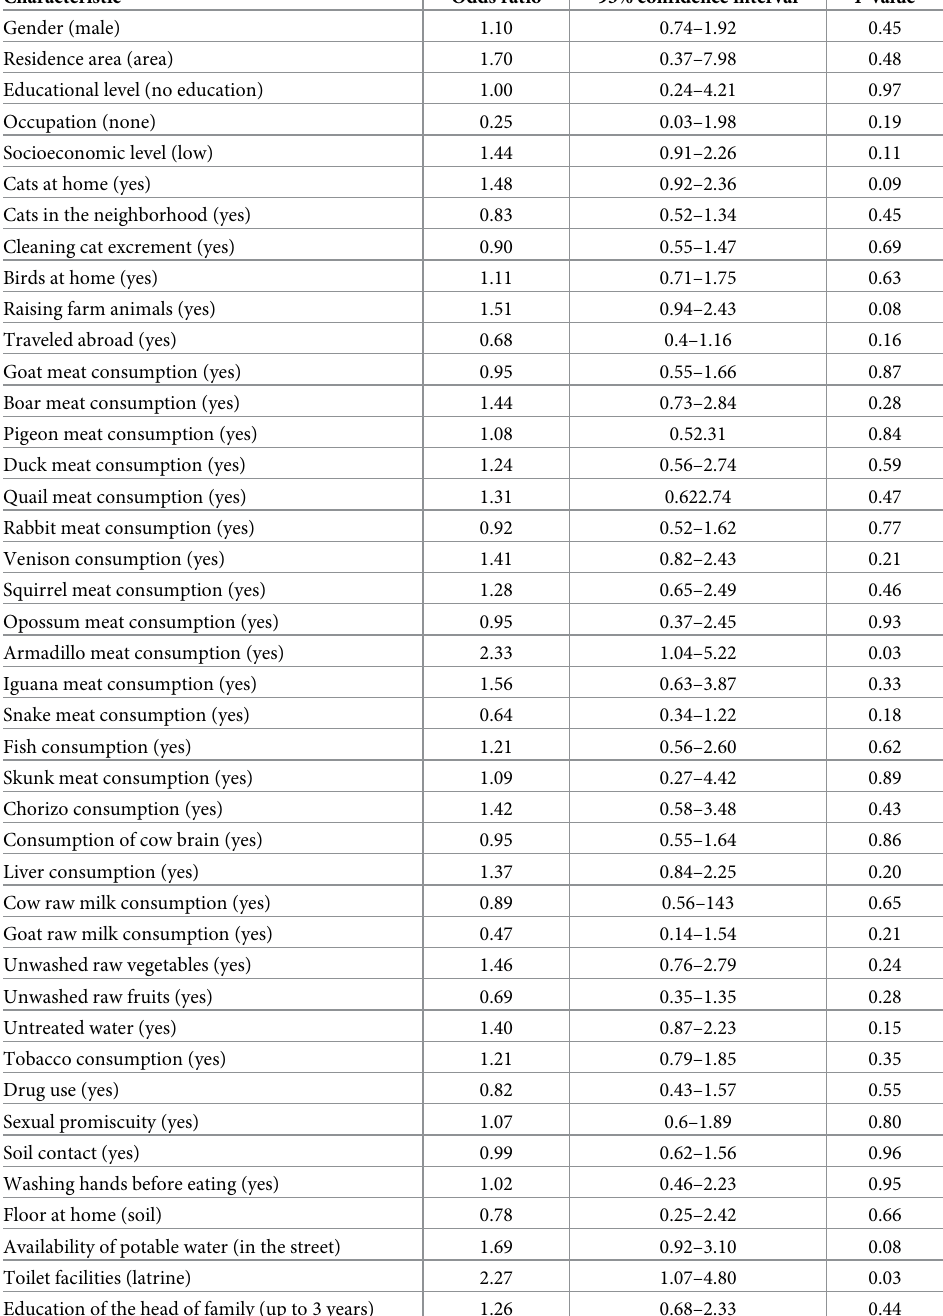
Table 4. Multivariate analysis of selected characteristics of people with alcohol consumption and their association with T . gondii infection.